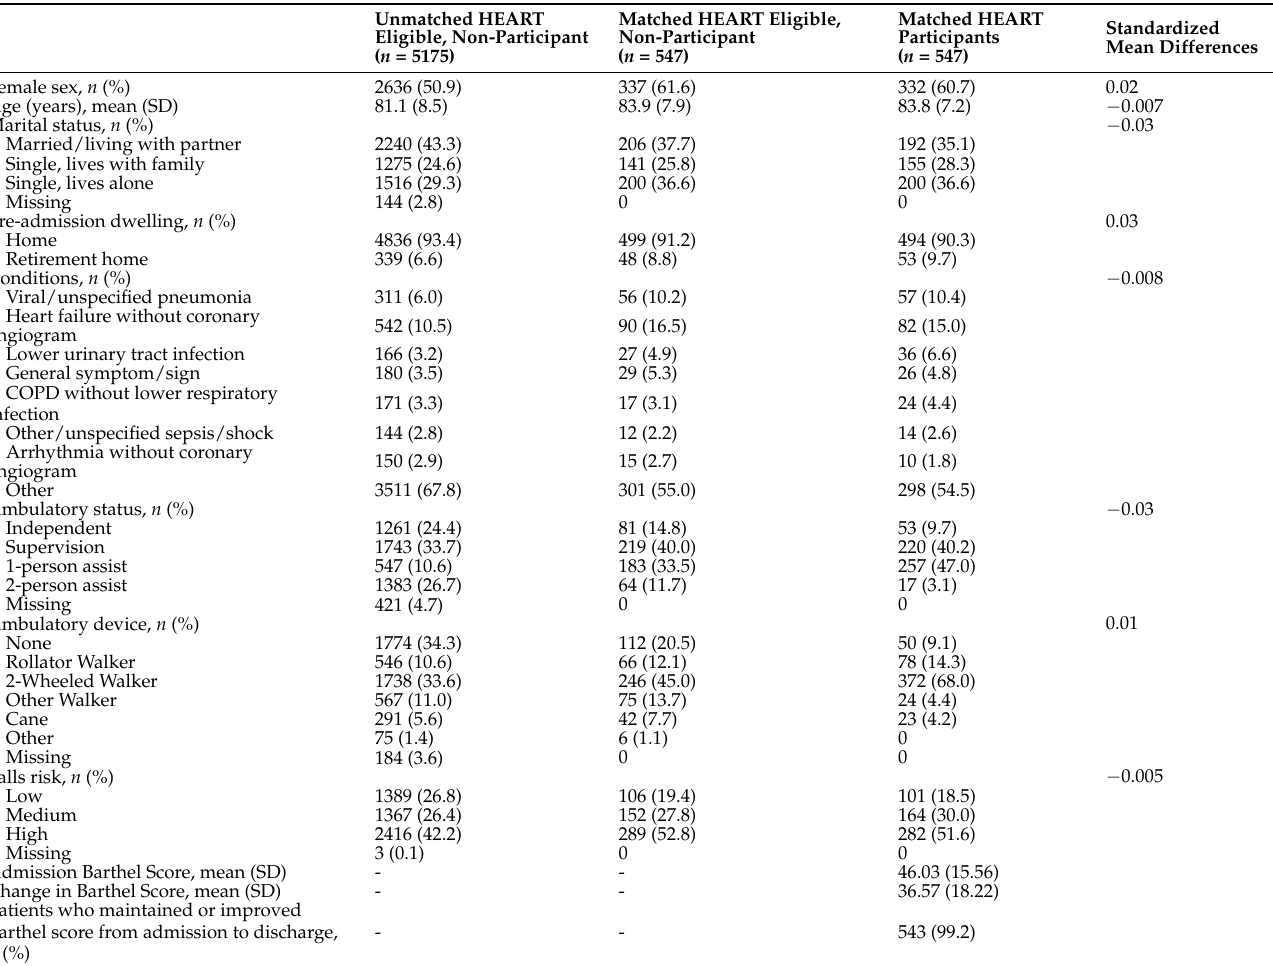
Table 1. Descriptive characteristics of study participants before and after propensity score